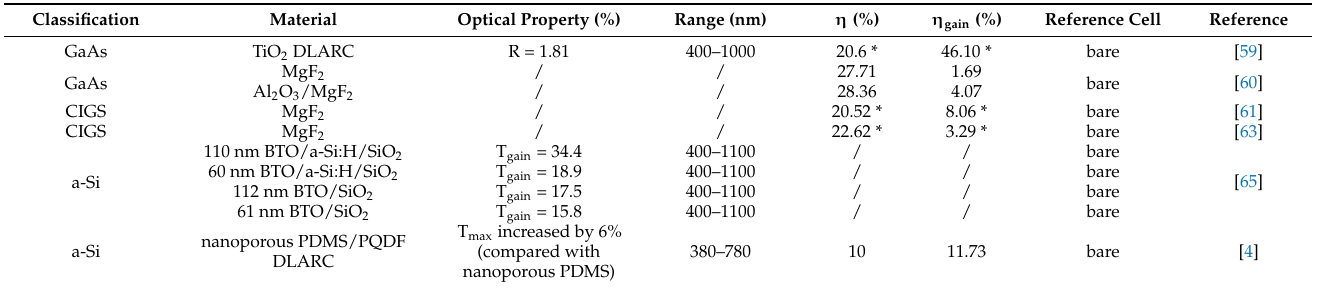
Table 2. The optical and electrical parameters of the second generation of solar cells with different ARCs. (* represents the simulated